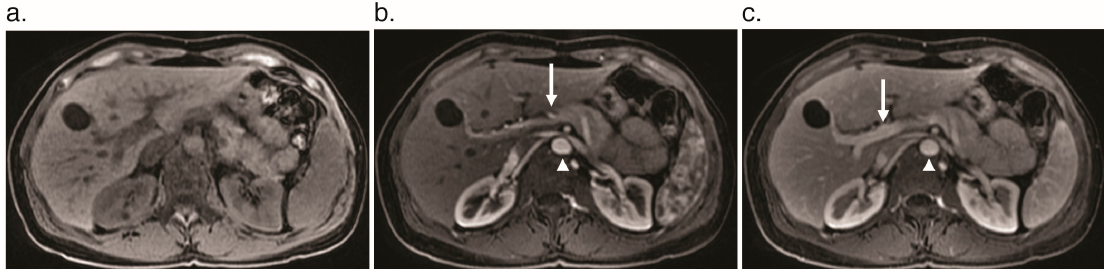
Figure 1. Contrast enhancement phases in a normal liver without vascular shunting on dynamic axial T 1 fat-saturated magnetic resonance imaging. ( a ) Pre-contrast phase. ( b ) Arterial phase shows enhancement of the aorta (arrowhead) and hepatic artery (arrow). ( c ) Portal venous phase shows enhancement of the portal vein (arrow) and slightly diminished enhancement of the aorta (arrowhead) relative to the arterial phase.